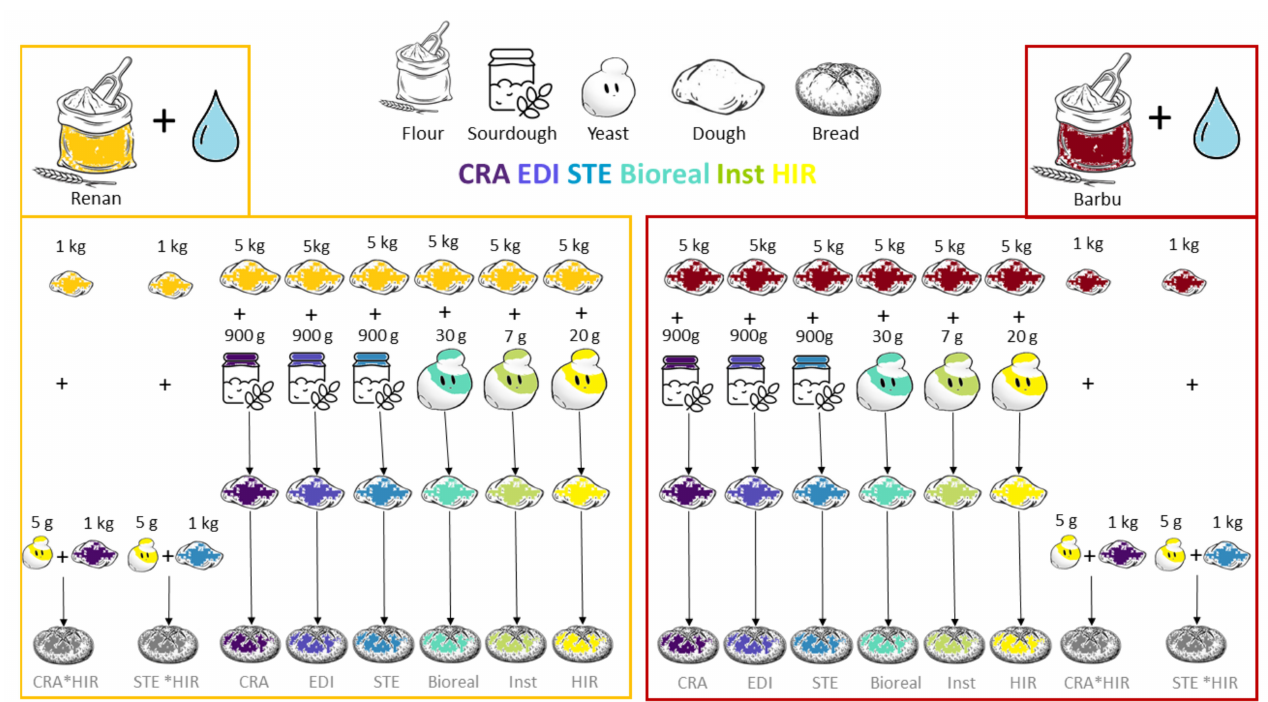
Figure 1. Bread-making design of the experiment. “CRA”, “EDI”, and “STE” refer, respectively, to the bakers Collectif Cravirolla, Edith Brissiaud, and St é phane, and “HIR”, “Bioreal”, and “Inst” refer, respectively, to the three commercial yeasts Hirondelle fresh yeast—Lesaffre, Bioreal organic fresh yeast—Europ-Labo, and Saf-instant instant